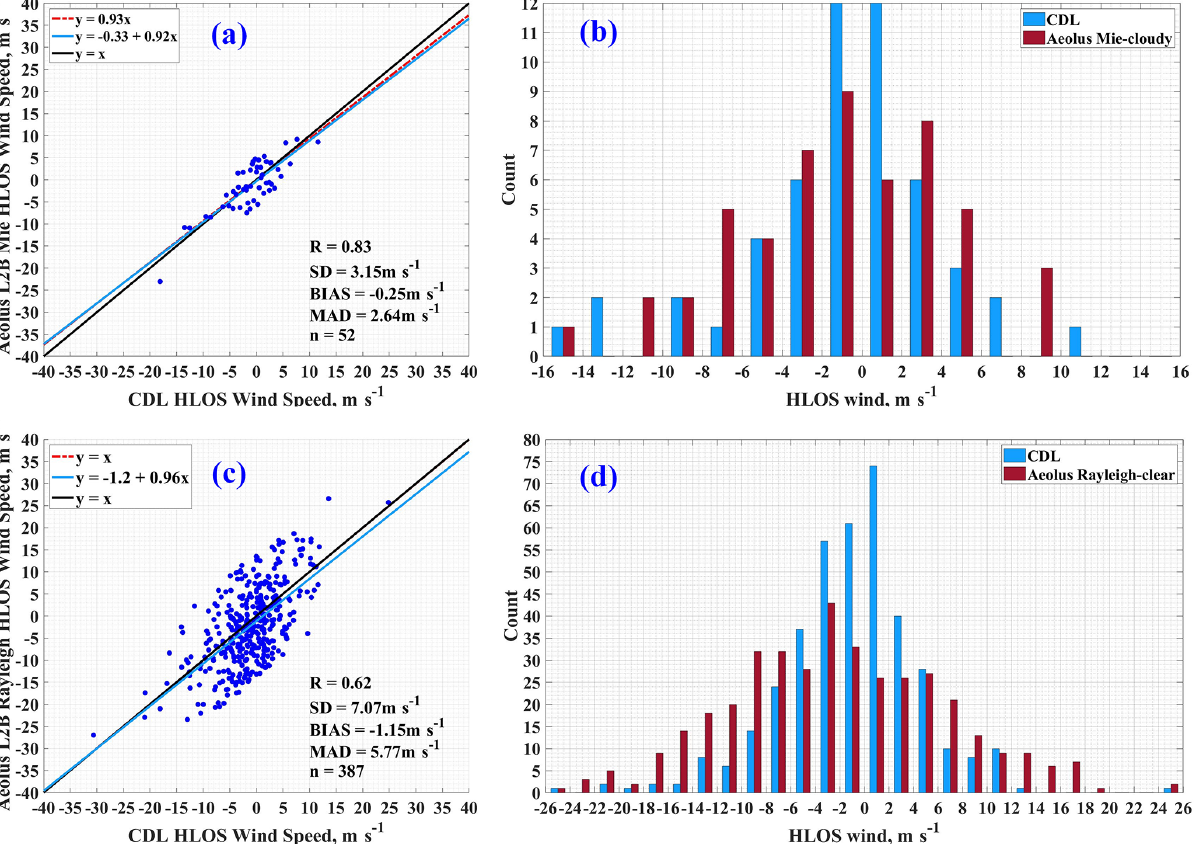
Figure 10. Comparisons of Aeolus L2B Rayleigh-clear HLOS wind velocities and Mie-cloudy HLOS wind velocities against those from CDLs. In panels (a) and (c) , the dotted red lines represent the y = ax fitting lines, the blue lines represent the y = ax + b fitting lines, and the black lines represent the y = x reference line. Panels (b) and (d) show the histogram of HLOS wind velocities, where the blue columns represent the count of CDL HLOS wind velocities, and the red columns represent the count of Aeolus HLOS wind